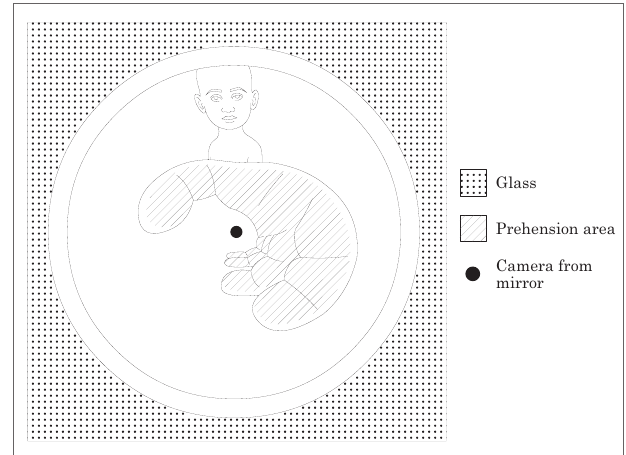
FIgURe 2 | hand image of the transparent cylinder reflected on the hyperbolic mirror and captured by the camera .